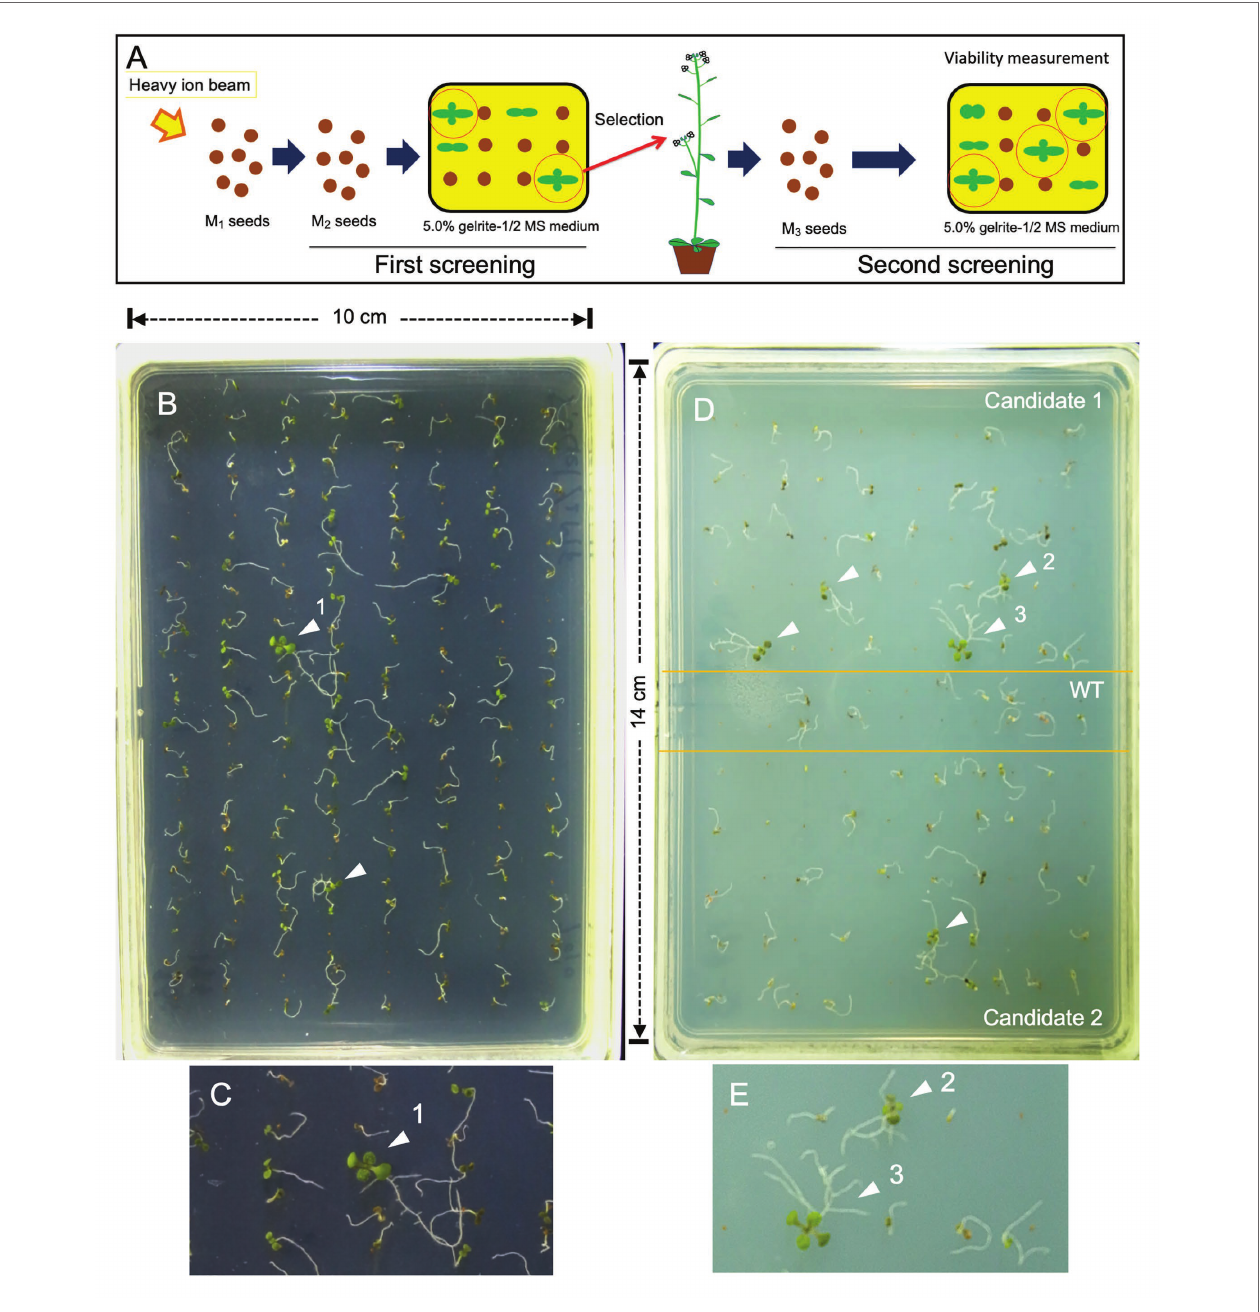
FIGURE 2 | Screening method. (A) Schematic presentation of the flow of screening. (B) First screening. Two hundred M 2 seeds were sown on 5% gelrite-1/2 MS medium, incubated for 10 days, and photographed. (C) Magnified image of seedling indicated by an arrowhead (number 1) shown in (B) . (D) Second screening. The M 3 seeds (50 grains each) of two candidate mutants were sown separately with wild type (WT) seeds (20 grains), incubated for 15 days, and photographed. (E) Magnified image of two seedlings indicated by arrowheads (numbers 2 and 3) shown in (D) . The arrowheads in (B–E) indicate surviving seedlings that had green true leaves and did not undergo necrosis. Note that true leaves of seedlings 1 and 3 can be easily seen, while those of seedling 2 are less developed and hardly visible even after image magnification. Lateral roots are seen in seedlings 1–3, but not in those not pointed out by an